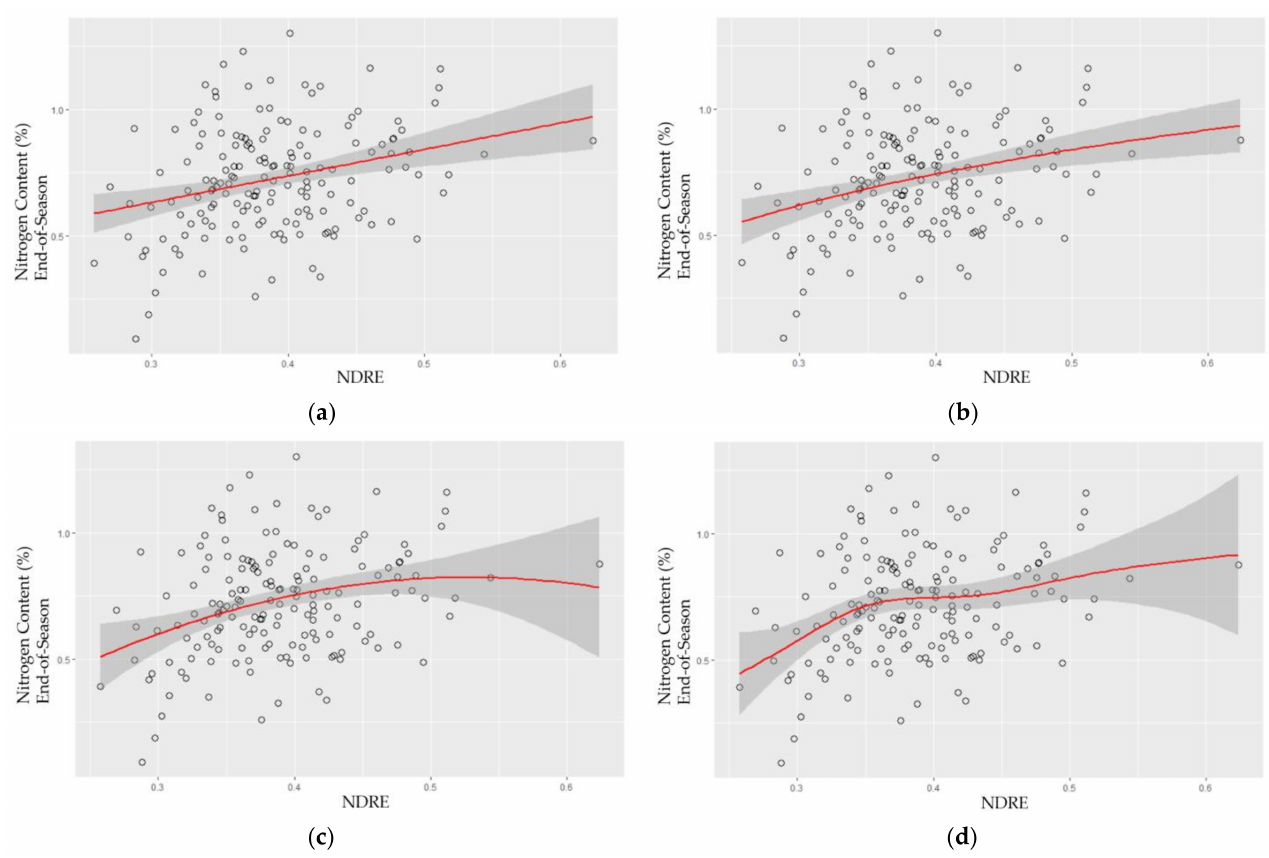
Figure 3. Nitrogen content model with normalized difference red edge (NDRE), ( a ) linear regression, ( b ) logarithm, ( c ) quadratic polynomial, vs. model ( d ) Generalized Additive Model (GAM). X -axis represents the vegetation index (NDRE), and y -axis represents N content (%) in